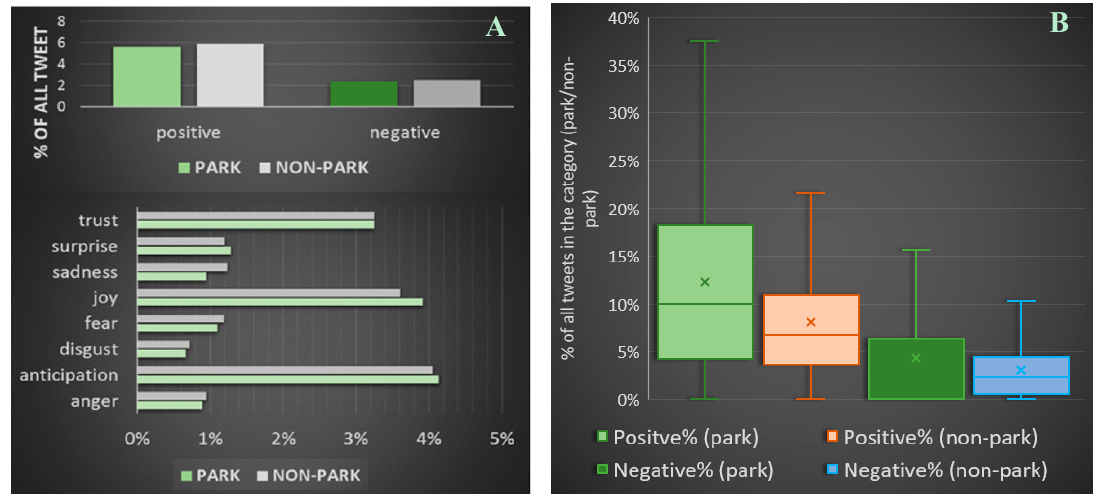
Figure 11. Percentage of sentiments and emotions for park tweets and non ‐ park tweets (( A ) all tweets considered in one step; ( B ) aggregated user ‐ level values).